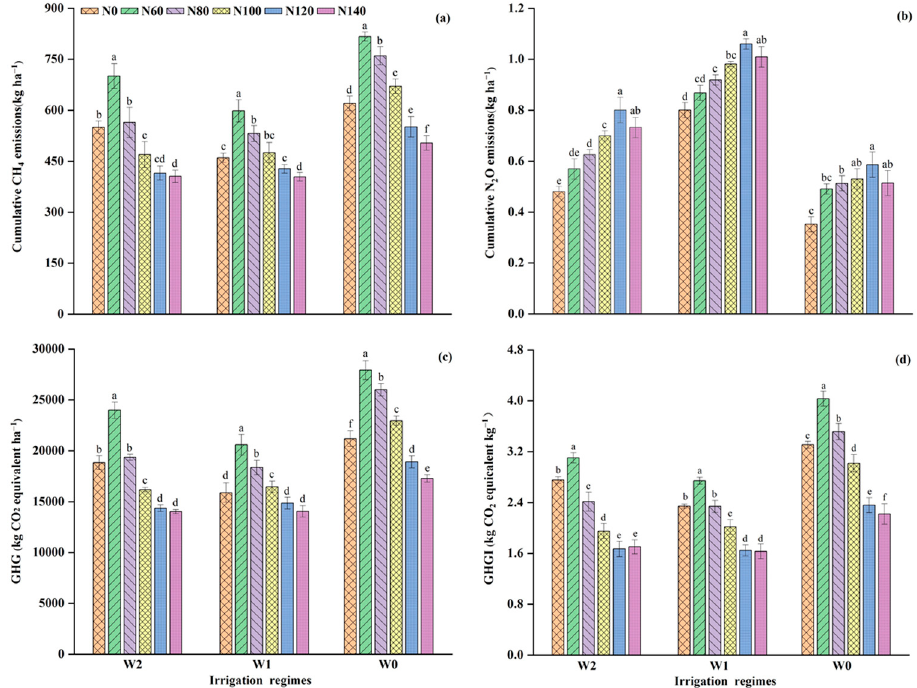
Figure 7. Cumulative emissions of ( a ) CH 4 , ( b ) N 2 O, ( c ) total global warming potential (GWP), and ( d ) greenhouse gas intensity (GHGI) affected by irrigation regimes with different N application rates. Different lowercase letters above the standard error bars indicate significant differences among treatments during the rice-growing season ( p < 0.05). Values followed by the different letter are significant different at p < 0.05.